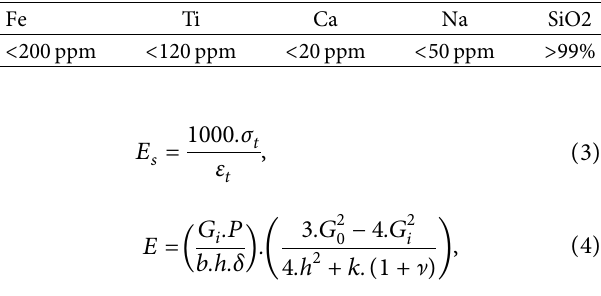
Table 3: Specifications of